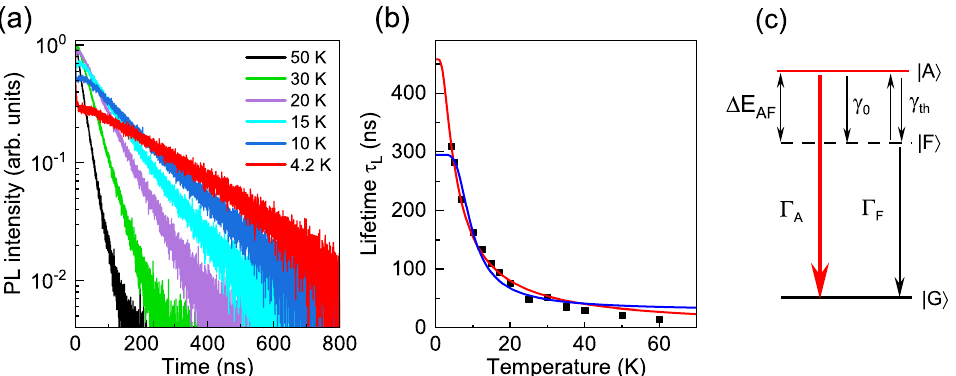
Figure 4. ( a ) PL decay measured at 4.2–50 K for zb-CdSe NCs with R = 1.85 nm. ( b ) Temperature dependence of the long PL decay lifetime (black squares) for the NCs from panel ( a ). Blue line shows the fit by Equation (2) with fitting parameters τ F = 295 ns, τ A = 14.2 ns, ∆ E AF = 2.7 meV. Red line shows the fit by Equation (3) based on the model considering the acoustic phonon activation of the dark exciton recombination [22] with parameters τ AC = 458 ns and E AC = 0.6 meV. ( c ) Conventional three-level model for the determination of the splitting ∆ E AF between bright | A (cid:105) and dark | F (cid:105) exciton